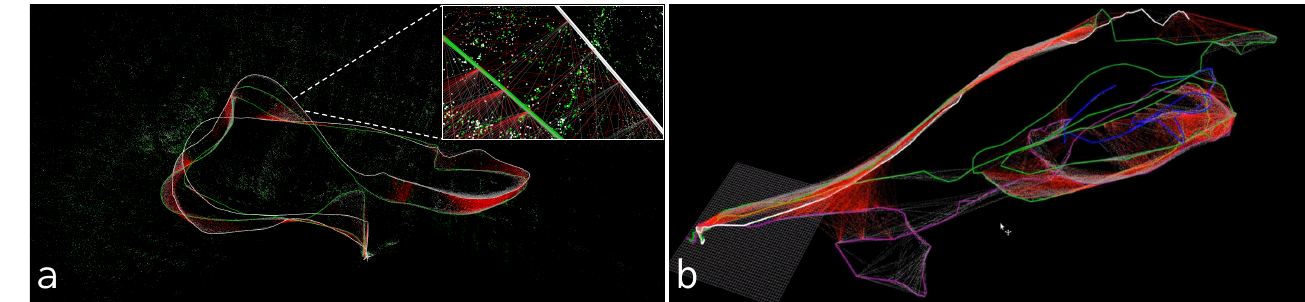
Figure 4. Snapshots of the CORB2I-SLAM map fusion experiment on EuRoC sequences [49]. ( a ) Map fusion among multiple agents. ( b ) Map fusion in a single agent as well as multiple